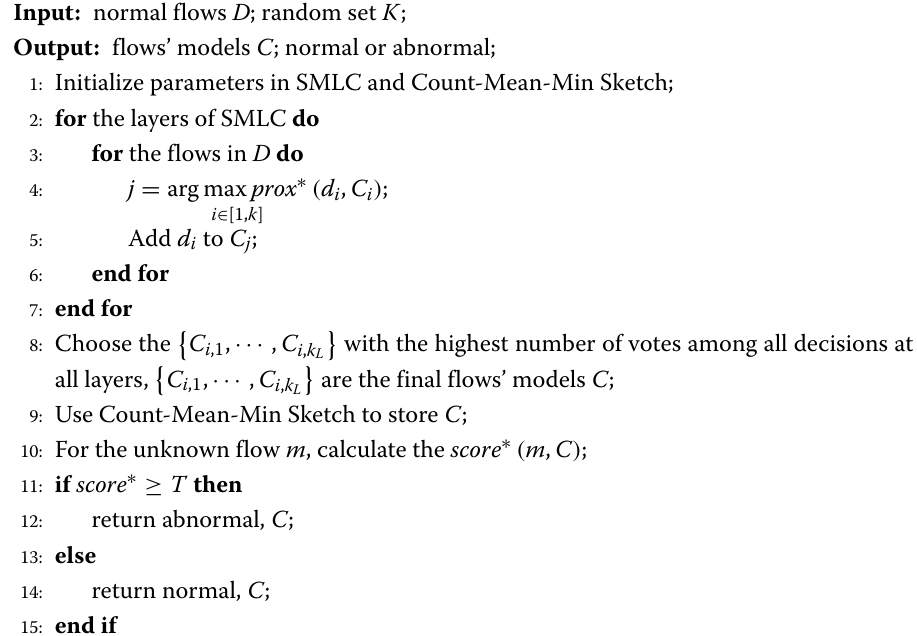
Algorithm 1 Improved ZOE